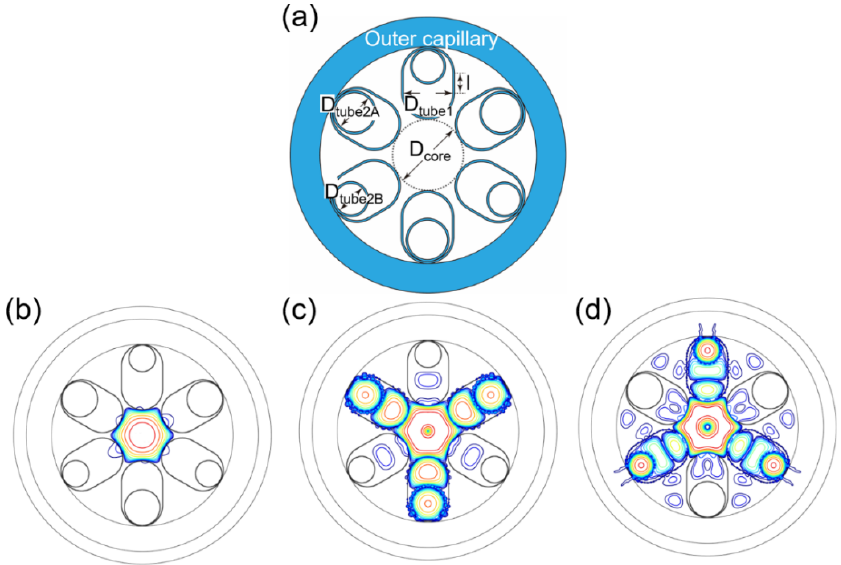
Figure 8. ( a ) Geometry of the NANF with hybrid extended cladding tubes. Three decibel (3-dB) contour plots of ( b ) LP 01 modes, ( b ) LP 11 modes, and ( c ) LP 21 modes of the NANF with hybrid extended cladding tubes.